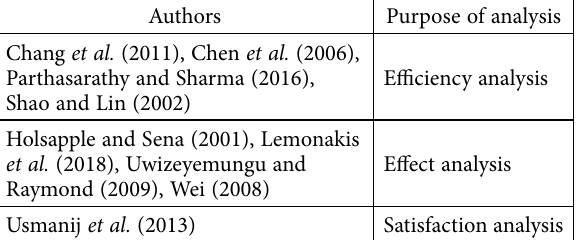
Table 3. Previous studies related to impact analyses